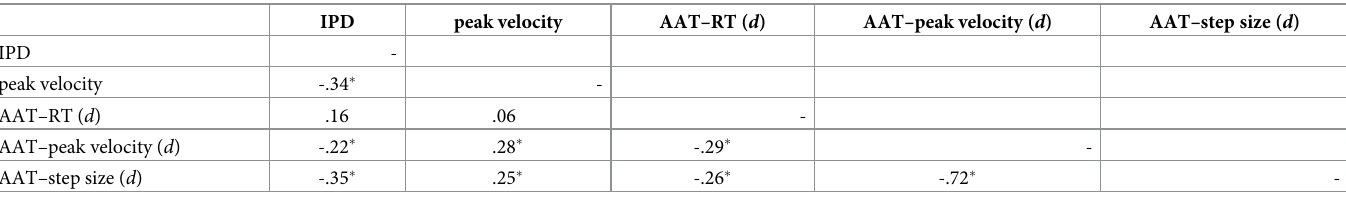
IPD Experiment: Individual mean IPD and peak velocity for the preferred target. AAT Experiment: Individual d -scores were computed subtracting approach trials from avoidance trials towards the preferred avatar sex and dividing through the pooled standard deviation for all outcome variables. Correlations with p ~ b ~ < 2 : 50% are marked with �